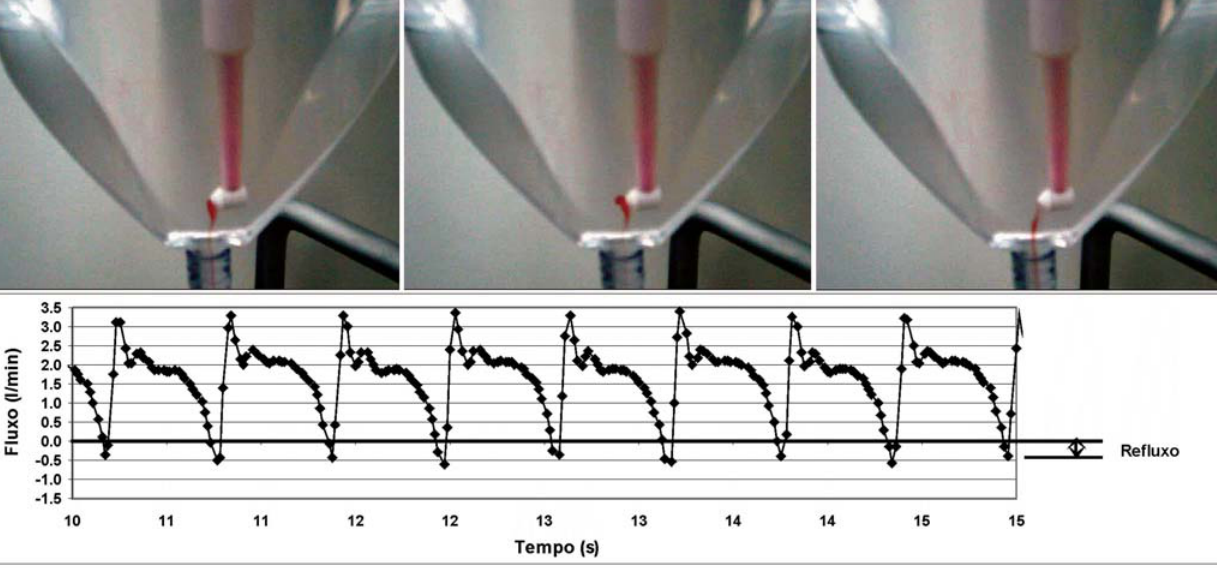
Fig. 6 – Visualização com respectiva medida de refluxo em reservatório de cardiotomia. Fluído análogo ao sangue. Bomba#1. PCDméd